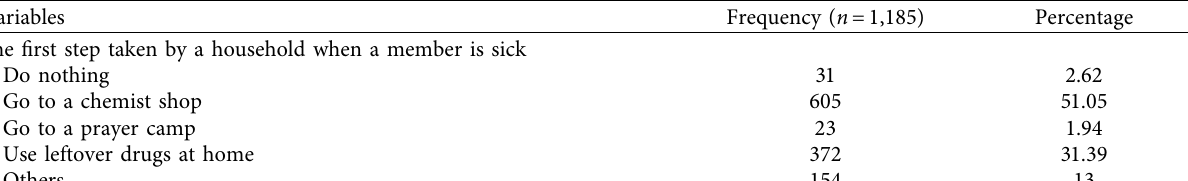
Table 2: Population characteristics and their implications on benefit